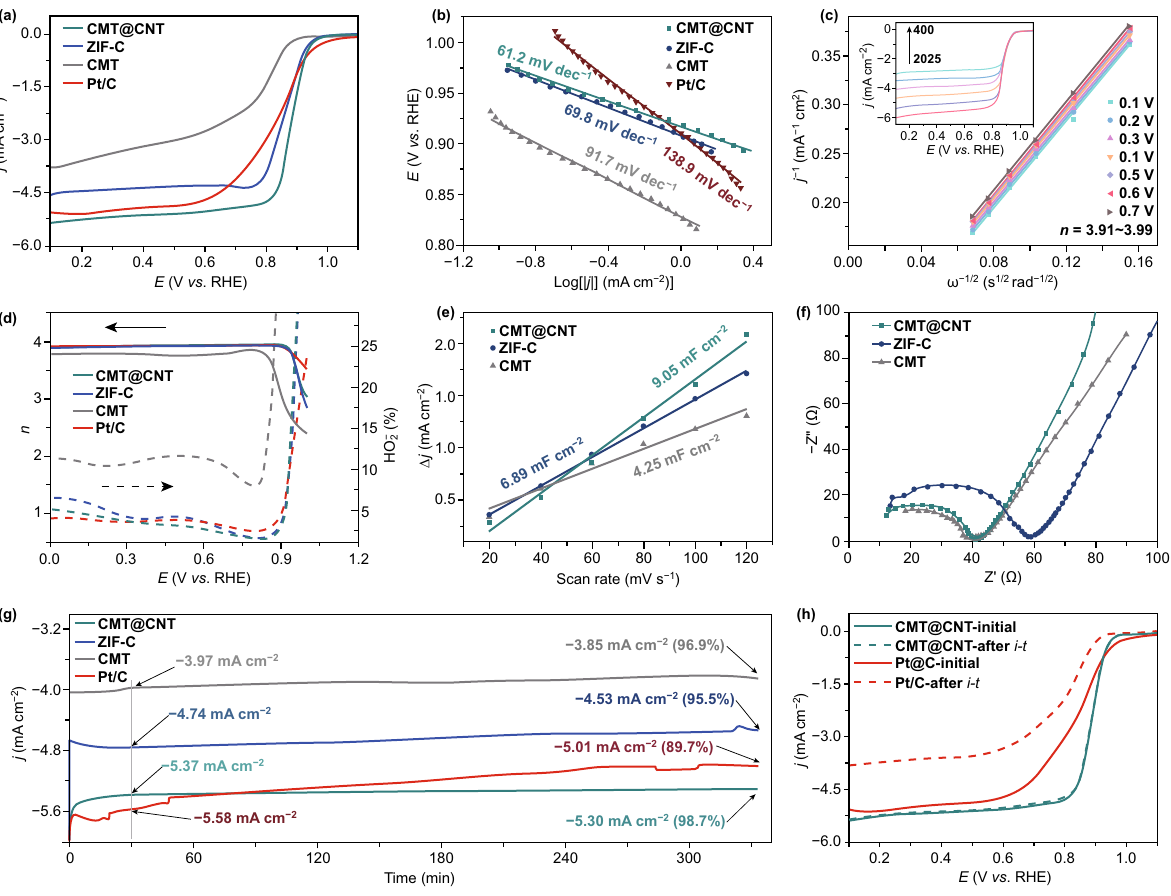
Fig. 3 ORR performance of CMT@CNT, ZIF-C, CMT, and Pt/C. a LSV curves and b Tafel slopes. c Koutecky–Levich plots of CMT@CNT, inset: LSV curves at various rotation speeds. d Electron transfer number and H 2 O 2 yield base on RRDE measurements. e ECSA and f Nyquist plots of CMT@CNT, ZIF-C, and CMT. g I - t curves, h LSV curves of initial and after i - t testing of CMT@CNT and